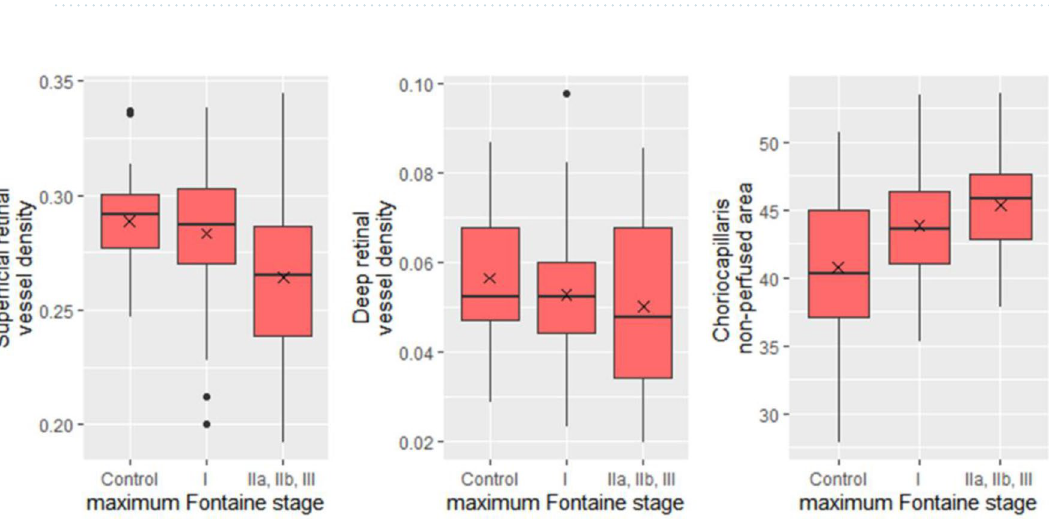
Table 1. Characteristics of the cohort. SD = standard deviation; OCT-A = optical coherence tomography angiogaphy; Student’s t-test, Wilcoxon rank sum test and Fisher’s exact test were used for statistical analysis.